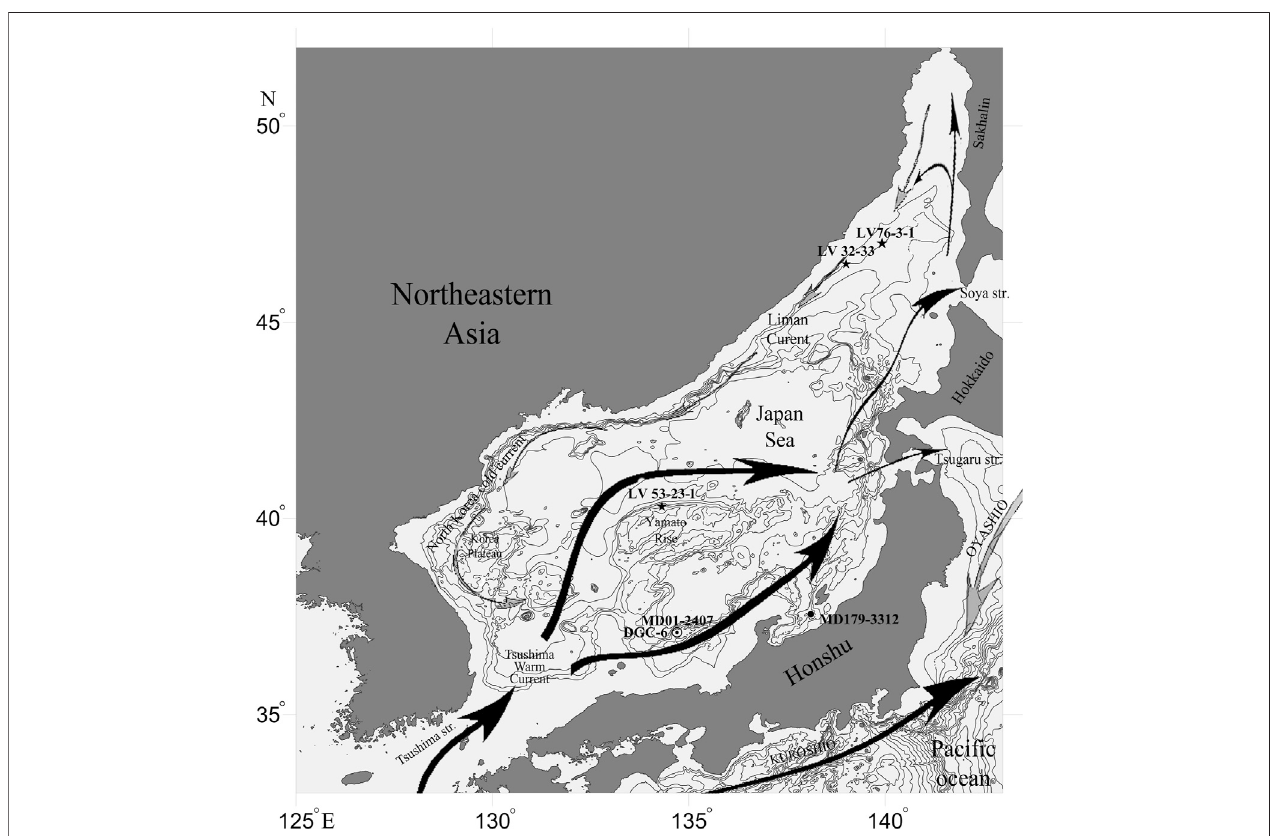
FIGURE 1 | The bathymetric map of the Sea of Japan showing the main surface water currents and the locations of sediment cores LV76-3-1 (studied in present paper), LV32-33 Gorbarenko et al. (2014), LV53-23-1 Gorbarenko et al. (2015), MD179-3312 Ishihama et al. (2014) and MD01-2407 and DGC-6 Yokoyama et al.